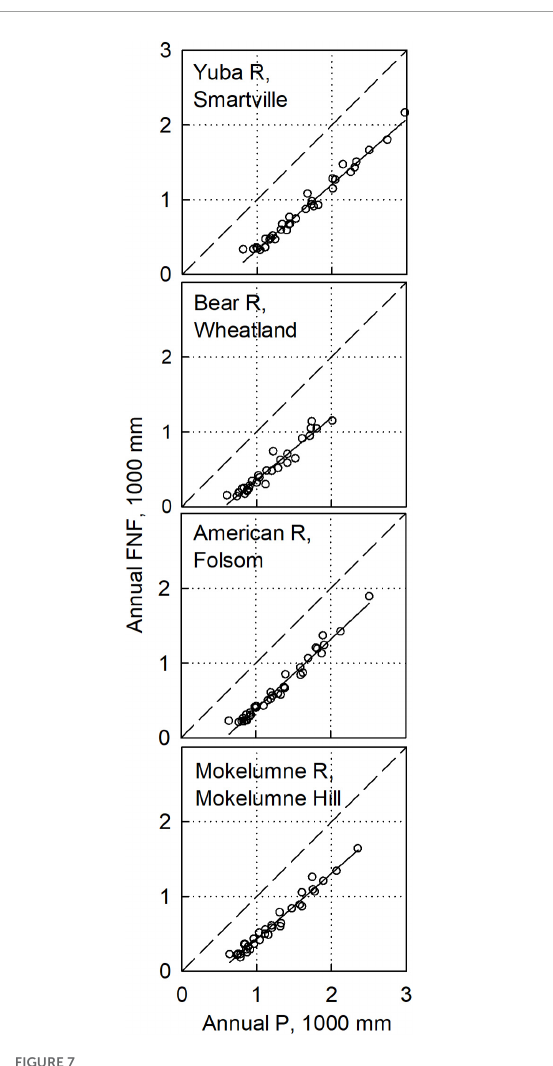
FIGURE7 Water-balance analysis for Full Natural Flow basins. The dashed diagonal is the 1:1